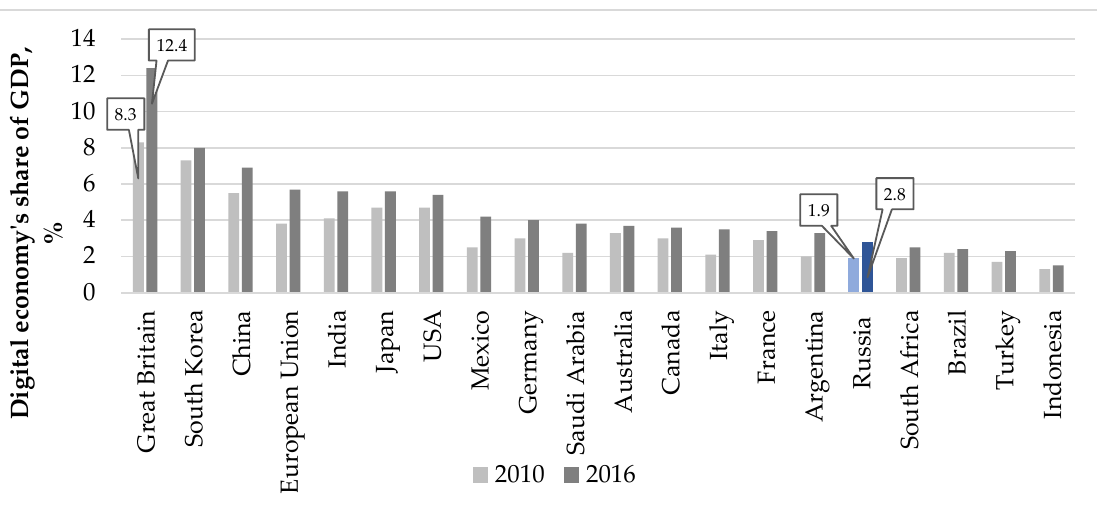
Figure 2. G20 countries ranking by the share of the digital economy in GDP for 2010 and 2016.